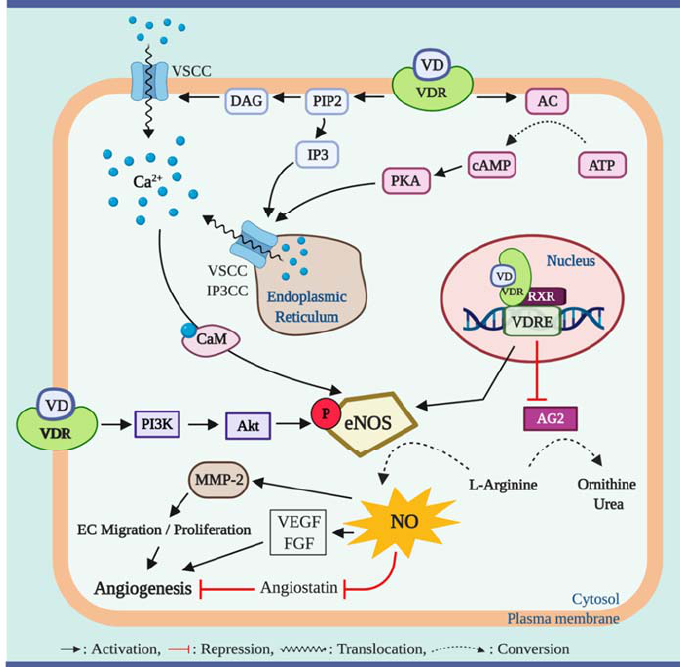
Figure 2. Role of vitamin D and vitamin D receptor (VDR) in regulating nitric oxide (NO) bioavailability. Ligand-bound VDR plays an important role in regulating NO synthesis via alterations in eNOS activity. Activation of plasma membrane VDR upregulates the activity of endothelial NO synthase (eNOS), a calcium dependent enzyme, by upregulating the formation of intracellular second messengers including adenylyl cyclase (AC), diacylglycerol (DAG) and inositol trisphosphate (IP3), which in turn result in calcium influx through the voltage-sensitive calcium channel (VSCC) in the plasma membrane and the sarcoplasmic reticulum and through the ip3 receptor / calcium channel (IP3CC) in the sarcoplasmic reticulum. The increased intracellular calcium concentrations facilitate the calcium-calmodulin (CaM) pathway to activate eNOS. In addition, plasma membrane VDR triggers eNOS activation through phosphorylation of serine-1779 (human serine 1177) on eNOS by activating the phosphoinositide 3-kinase (PI3K) / protein kinase b (Akt) pathway. Furthermore, genetic action of vitamin D via the nuclear VDR promotes eNOS expression, which synthesizes NO from L-arginine, and suppresses arginase-2 (AG2) expression, which inhibits eNOS activity by hydrolyzing the substrate for NO synthesis (arginine) to ornithine and urea. Increased NO production promotes angiogenesis by upregulating gene expression of matrix metalloproteinase 2 (MMP-2) which improves endothelial cell (EC) migration and proliferation capacity. In addition, NO mediates angiogenetic activity of the cell via upregulation of vascular endothelial growth factor (VEGF) and fibroblast growth factor (FGF) and suppression of the angiogenesis inhibitor,